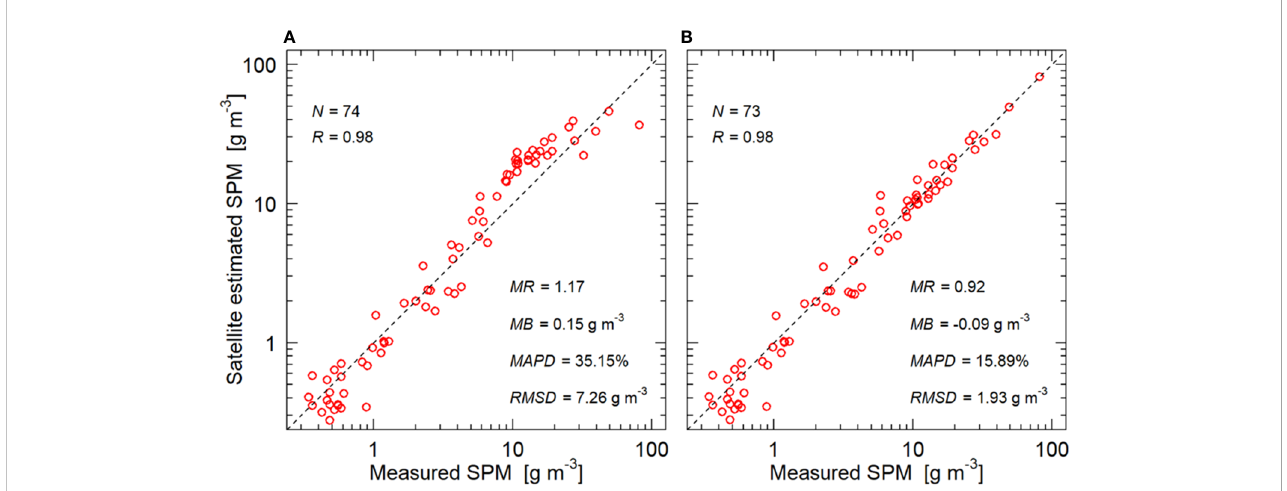
FIGURE 4 Scatter plot between measured and satellite-derived SPM concentrations; (A) based on the default Nechad et al. (2010) approach, using one single spectral band ( l = 665 nm); (B) based on regional adapted algorithm, which implies the usage of two spectral bands ( l = 665 nm and l = 865 nm); N is the number of match-ups, R - the correlation coef fi cient, MR - median ratio between observed and predicted, MB - median bias, MAPD - median absolute percentage difference and RMSD - root mean square